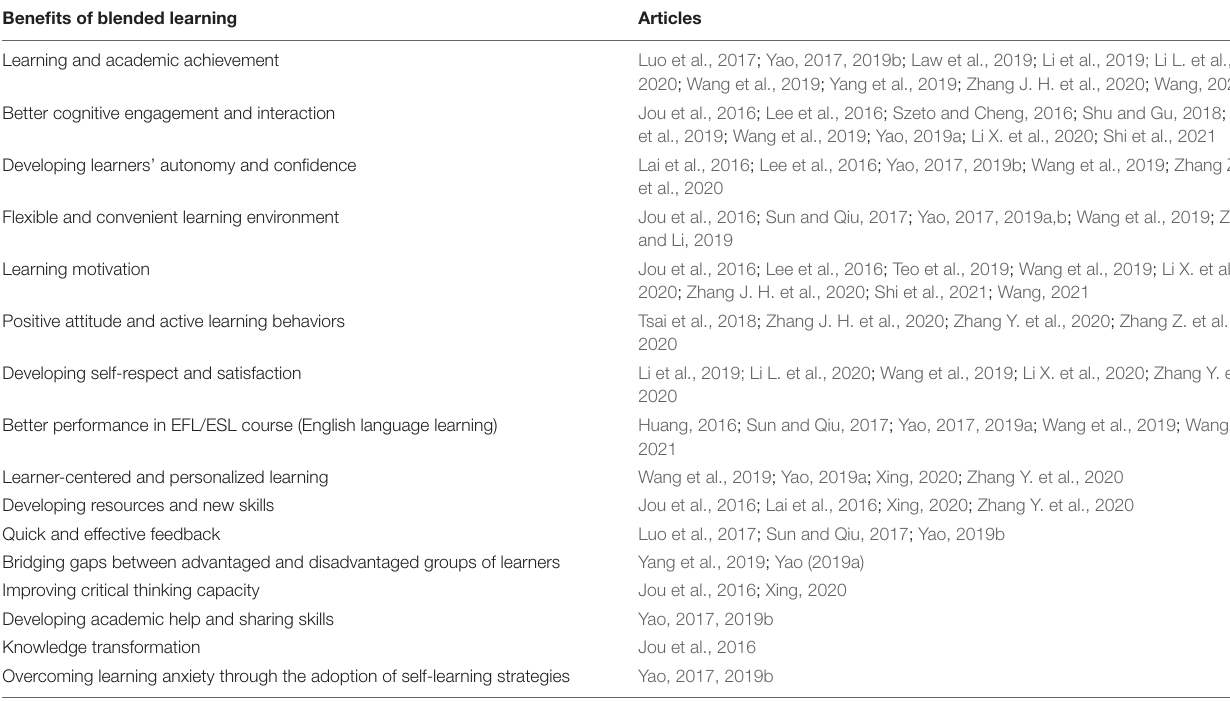
TABLE 5 | The advantages of BL in Chinese higher education from this